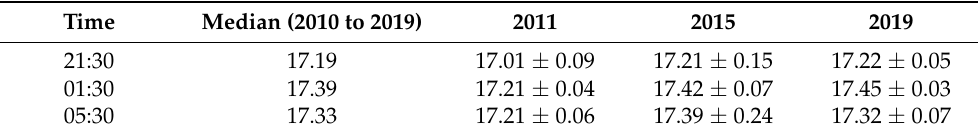
Table 5. Binned Winter Evolution in Johnson R (mag/arcsec 2